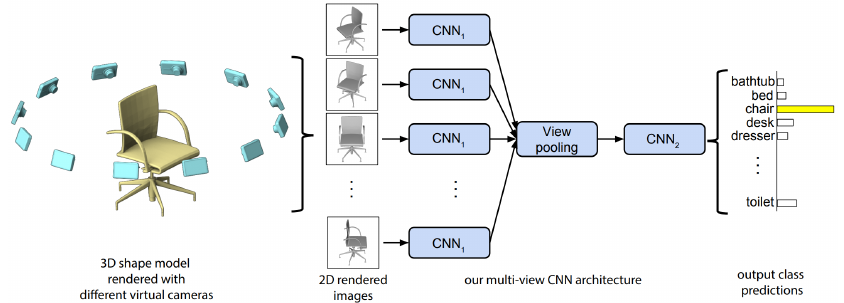
Figure 5. Multi-view CNN. Rendered 2D images are acquired with virtual cameras and fed into independent CNNs (CNN 1 ). Feature maps are aggregated into a single feature map describing a 3D object. This is passed into a second CNN (CNN 2 ) for classification. Image source: